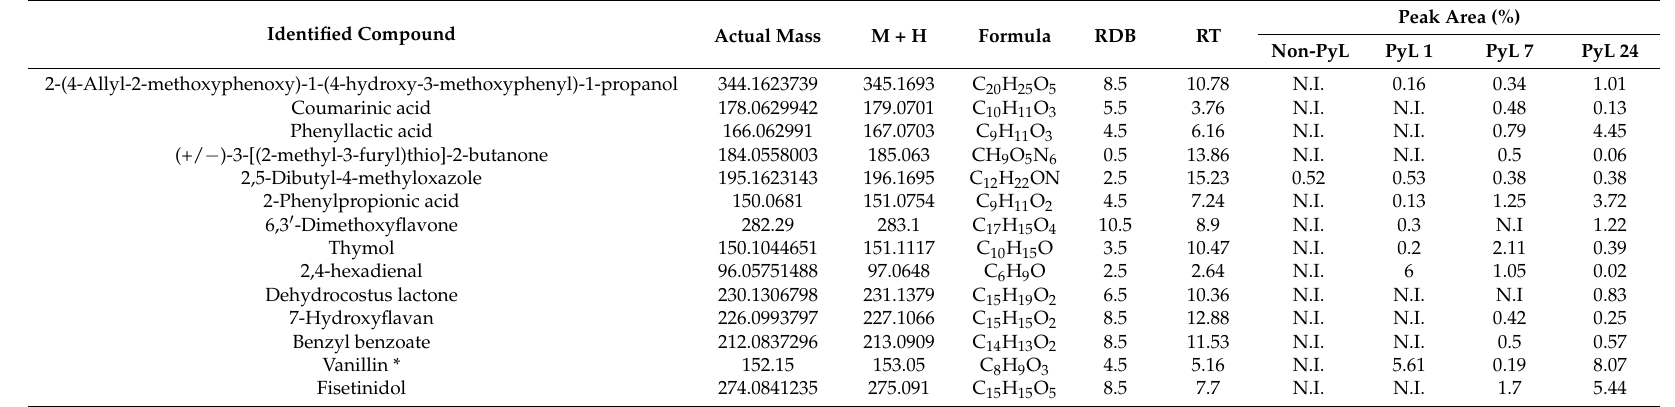
Table 1. HPLC-MS/MS and metabolomic analysis (XCMS Bioinformatics Platform) was used for the putative identification of compounds from pyrolytic lignins. Formula, actual mass, M + H, Ring and Double-Bond (RDB), Retention Time (RT), and peak area (%) among reported